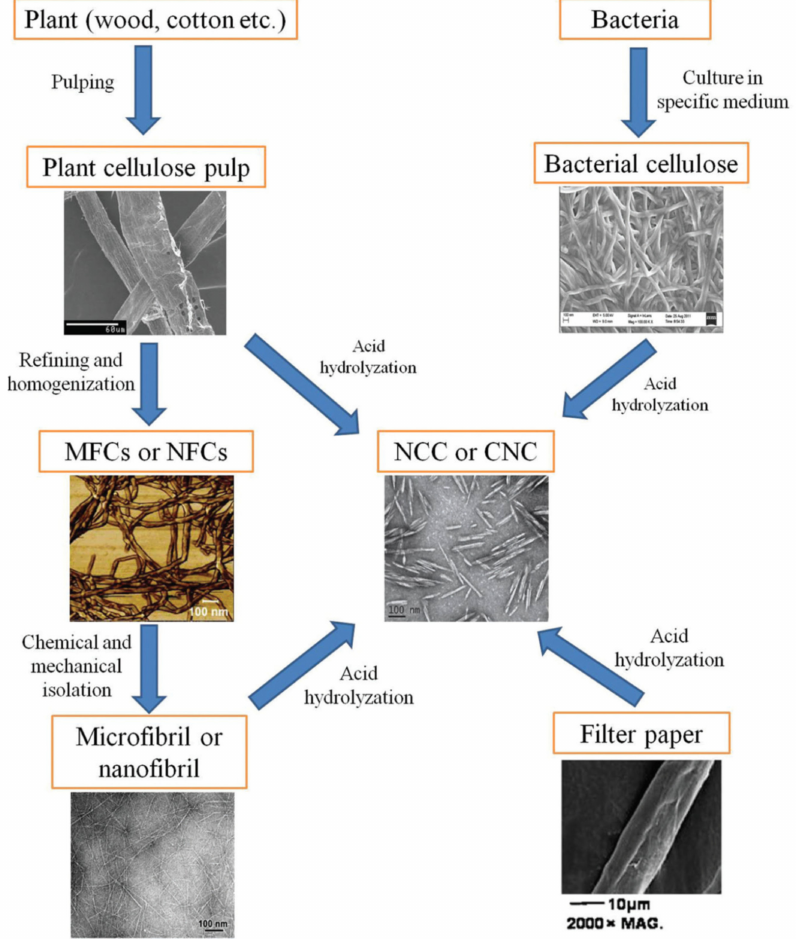
Figure 4. Relationship between different kinds of nanocelluloses [159]. (Reproduced with copyright permission from Creative Commons Attribution License